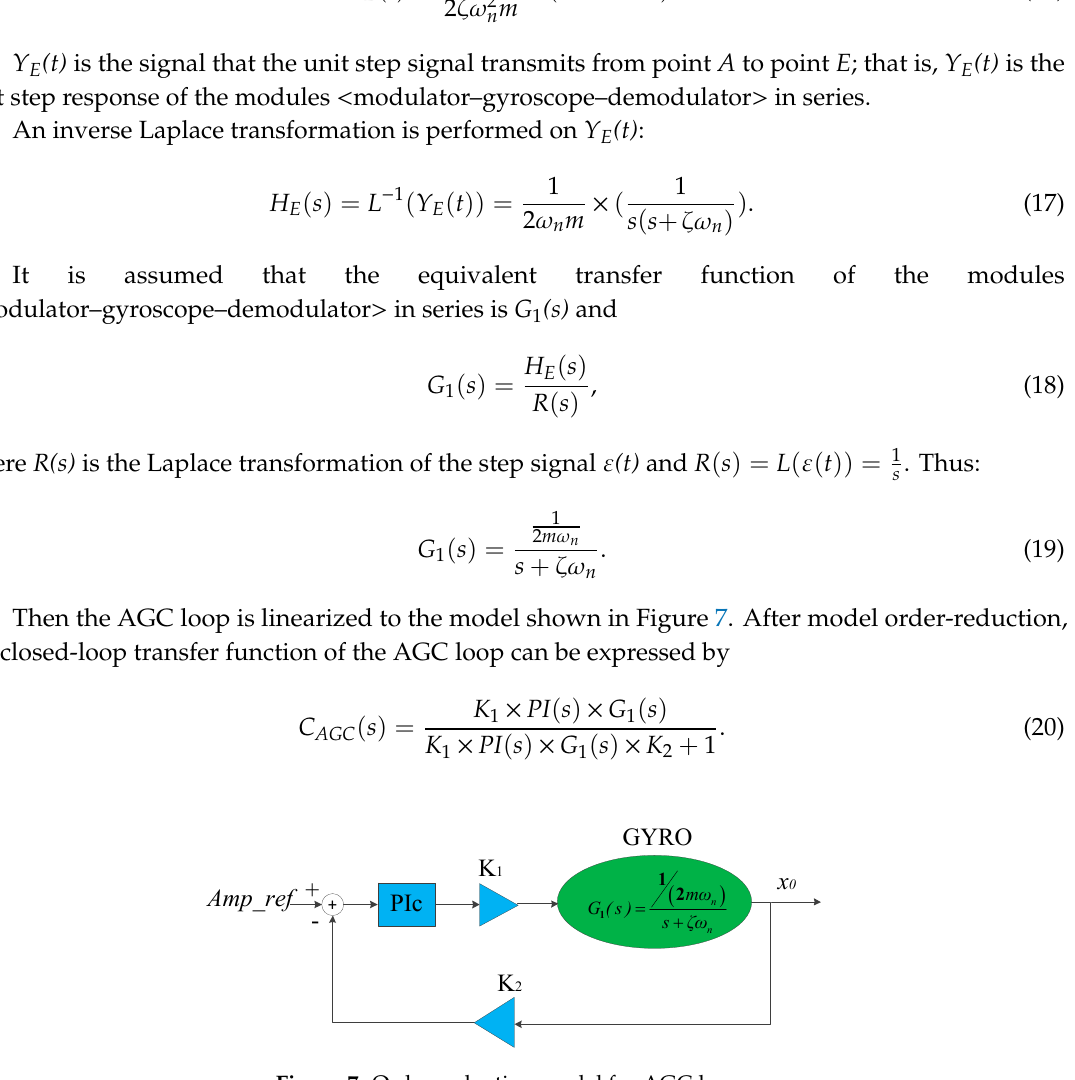
Figure 7. Order ‐ reduction model for AGC loop. Figure 7. Order-reduction model for AGC